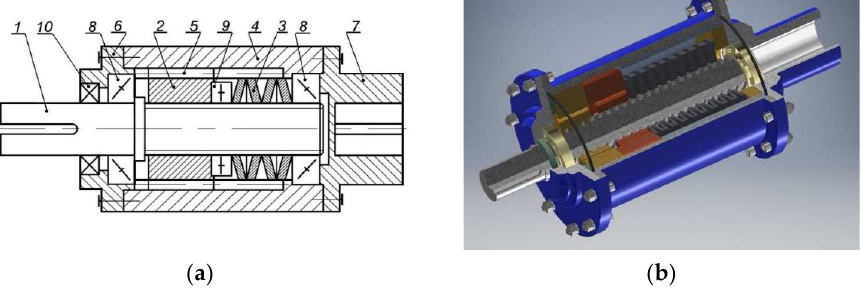
Figure 2. Design ( a ) and example ( b ) of a torsionally flexible metal clutch [62]; designations: 1—clutch shaft, 2—sliding sleeve, 3—set of disc springs, 4—clutch housing, 5—moving splined coupling, 6—cover, 7—clutch hub, 8—cone bearings, 9—thrust bearing, 10—sealing ring.